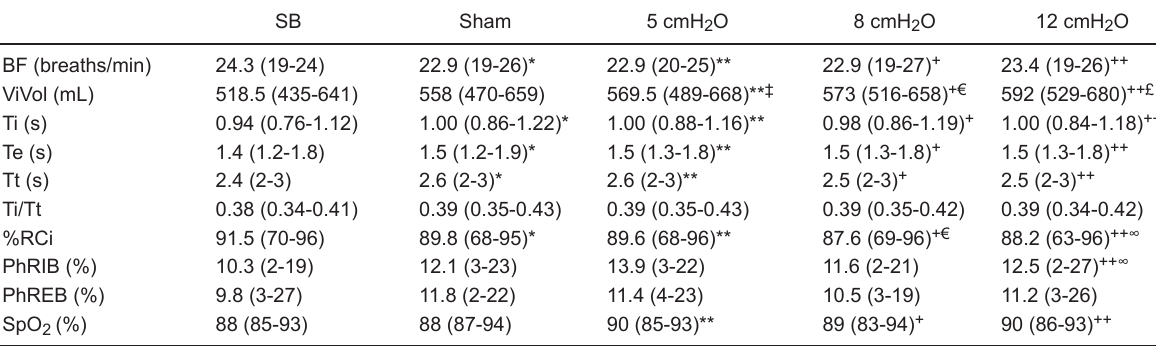
Data are reported as median (first quartile-third quartile) for 18 patients. All patients were submitted to SB, sham and 5, 8 and 12 cm -